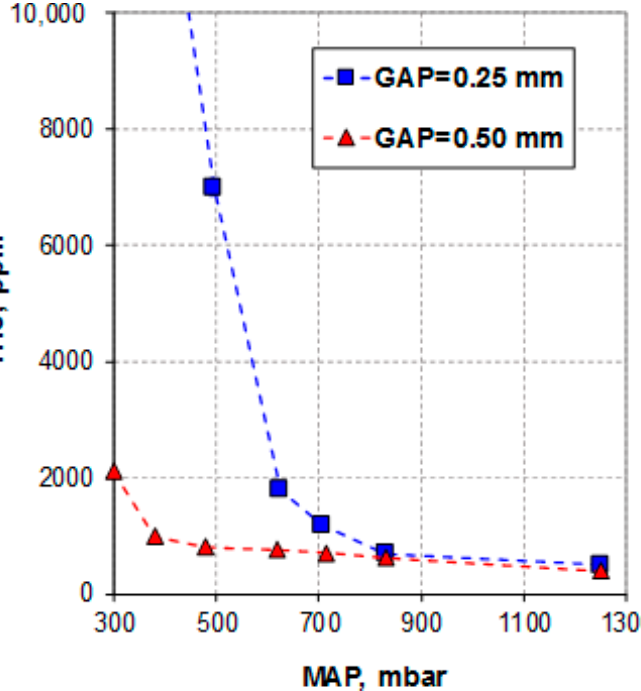
Figure 13. Effect of the spark plug gap on THC emissions as a function of MAP (data recorded at 1500 rpm, SA 23 CAD and ignition energy 300 mJ).